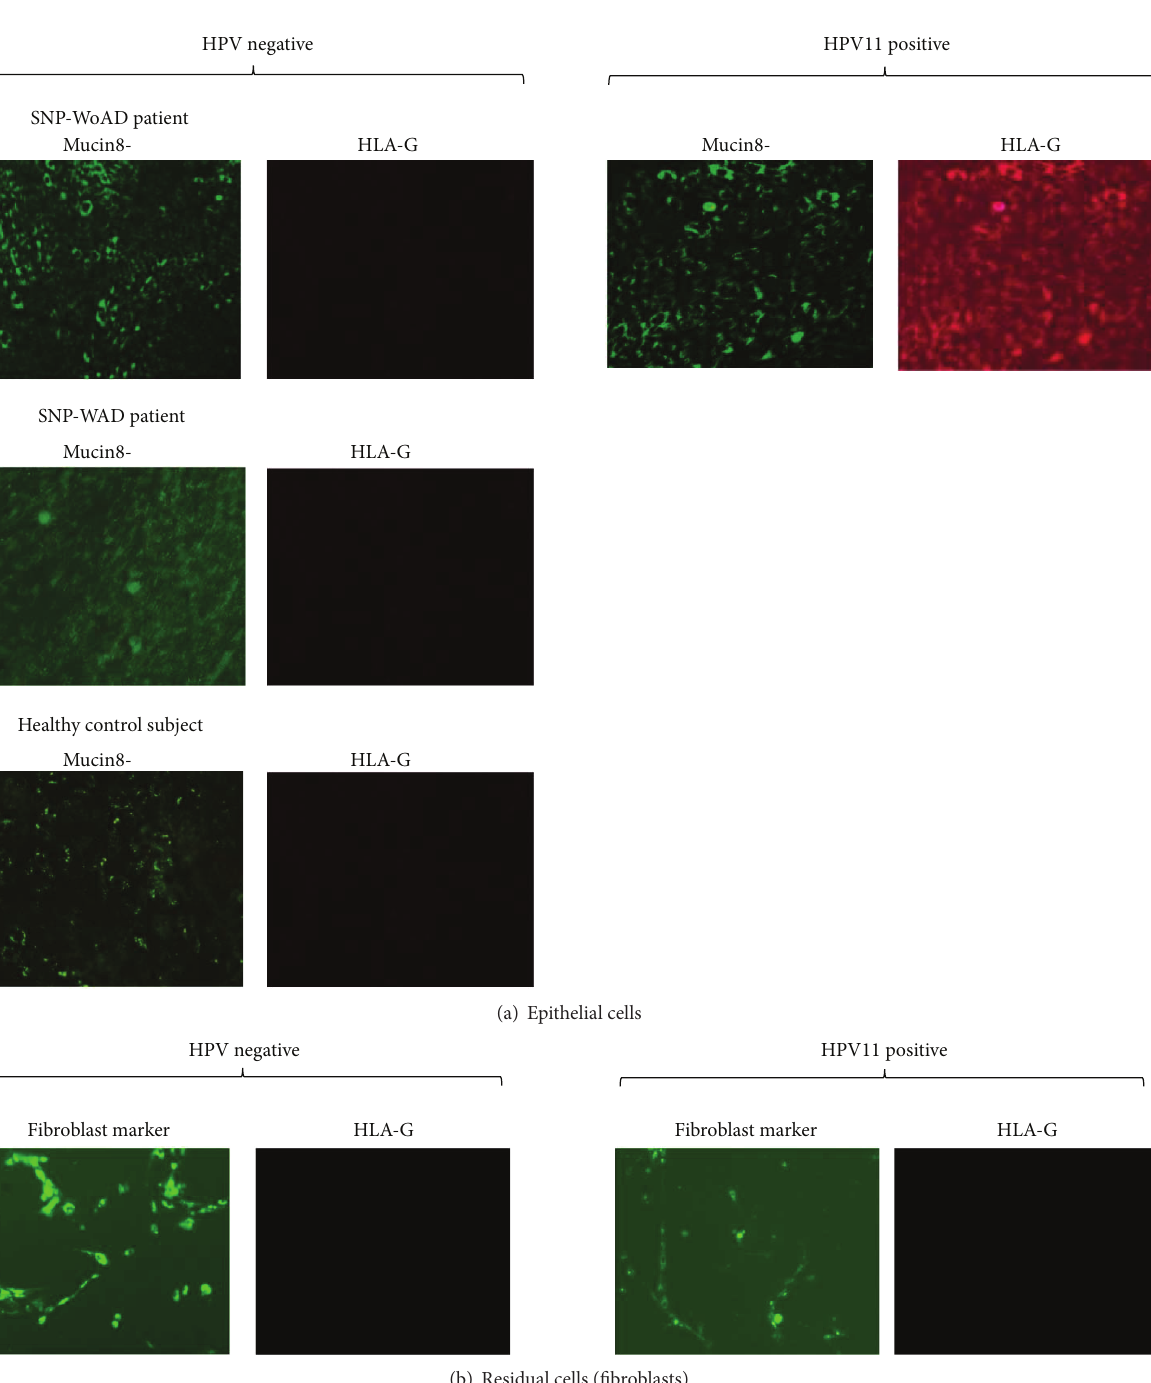
Figure 2: Immunofluorescence analysis of (a) epithelial cells and (b) residual cells (fibroblasts) from representative SNP-WoAD and SNP- WADpatientsandcontrols.Thecellswerestainedwithanti-Mucin8-FITCorfibroblastmarker-FITC(SantaCruzBiotechnology)and87G-PE